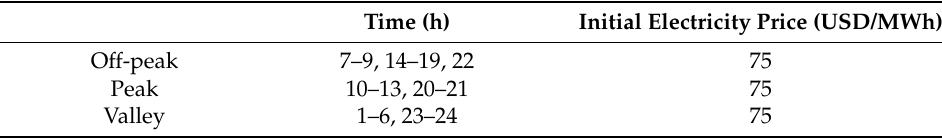
Table 1. Three periods in the TOU electricity price.